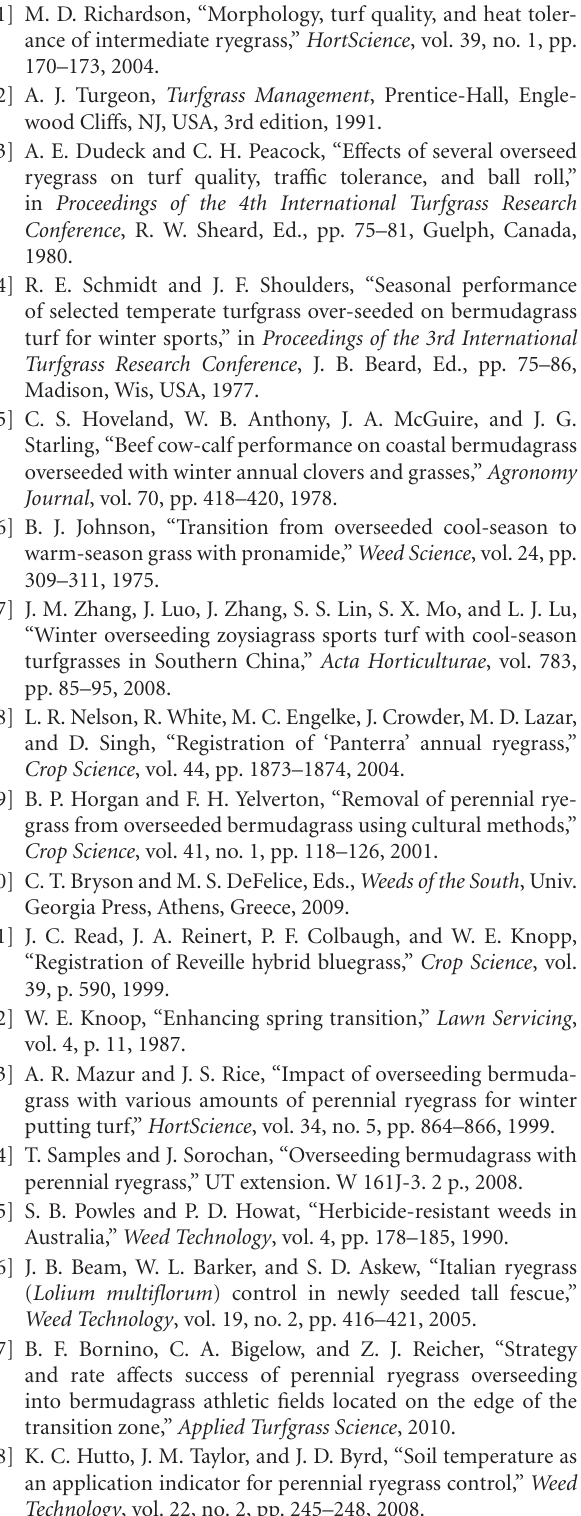
Table 6: Persistence of three overseeded species one year after seeding as a ff ected by foramsulfuron application timing in 2004 and 2005 for the second experiment. a